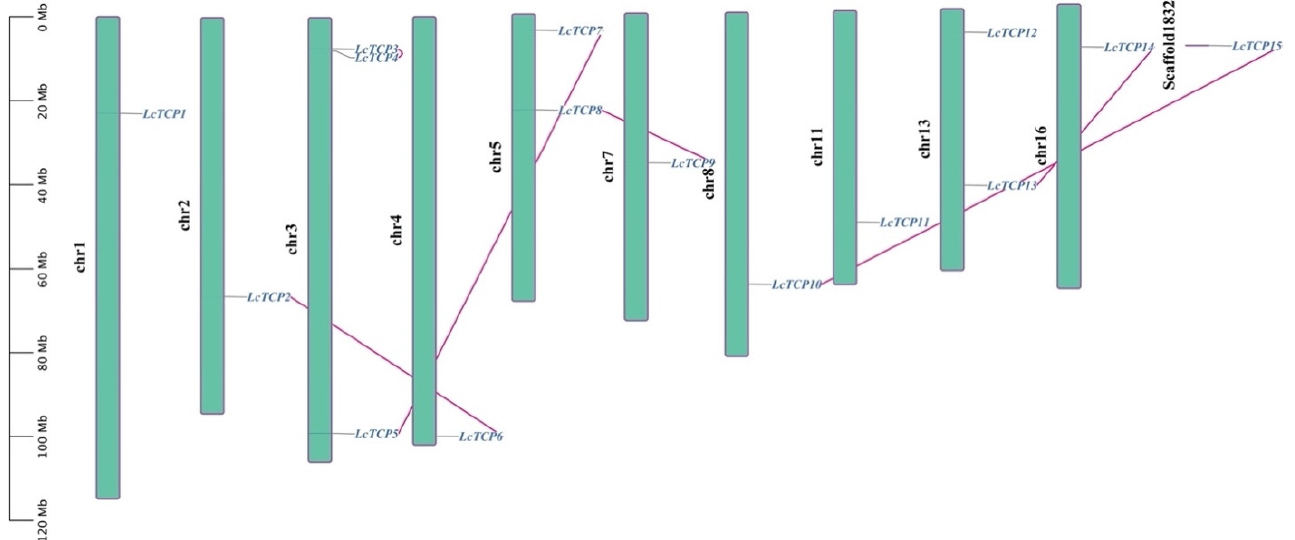
Figure 4. Gene arrangement and chromosome patterns of the LcTCP s. Chromosome structures are depicted in green rods, while the gene locations are labeled on the chromosomes. Purple lines represent gene linkage and collinearity within the L. Chinese TCP genome.